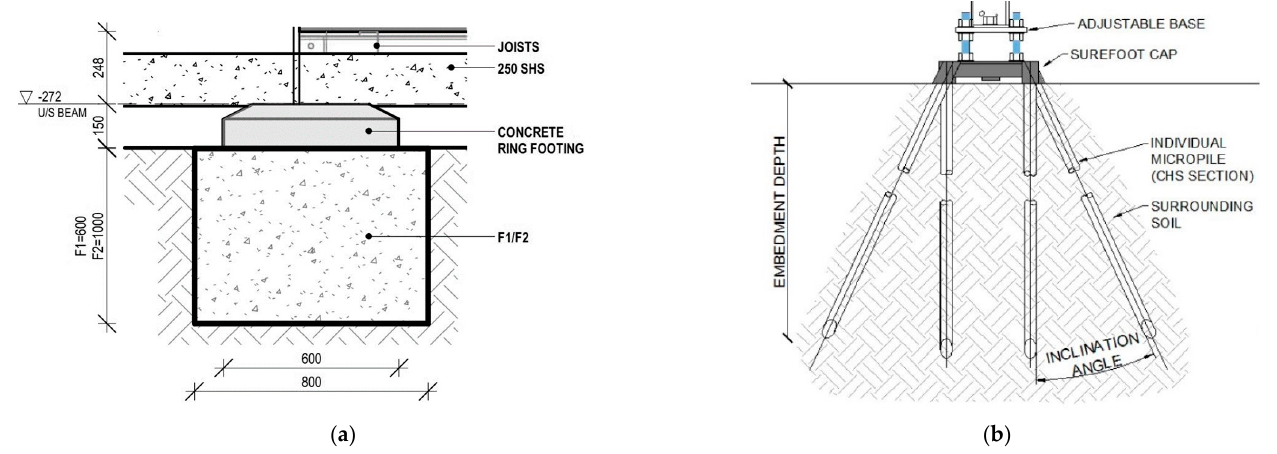
Figure 5. ( a ) Traditional footing design; mass concrete footing with a concrete ring to separate the building; ( b ) concrete free micropile system used as the foundation of L3.